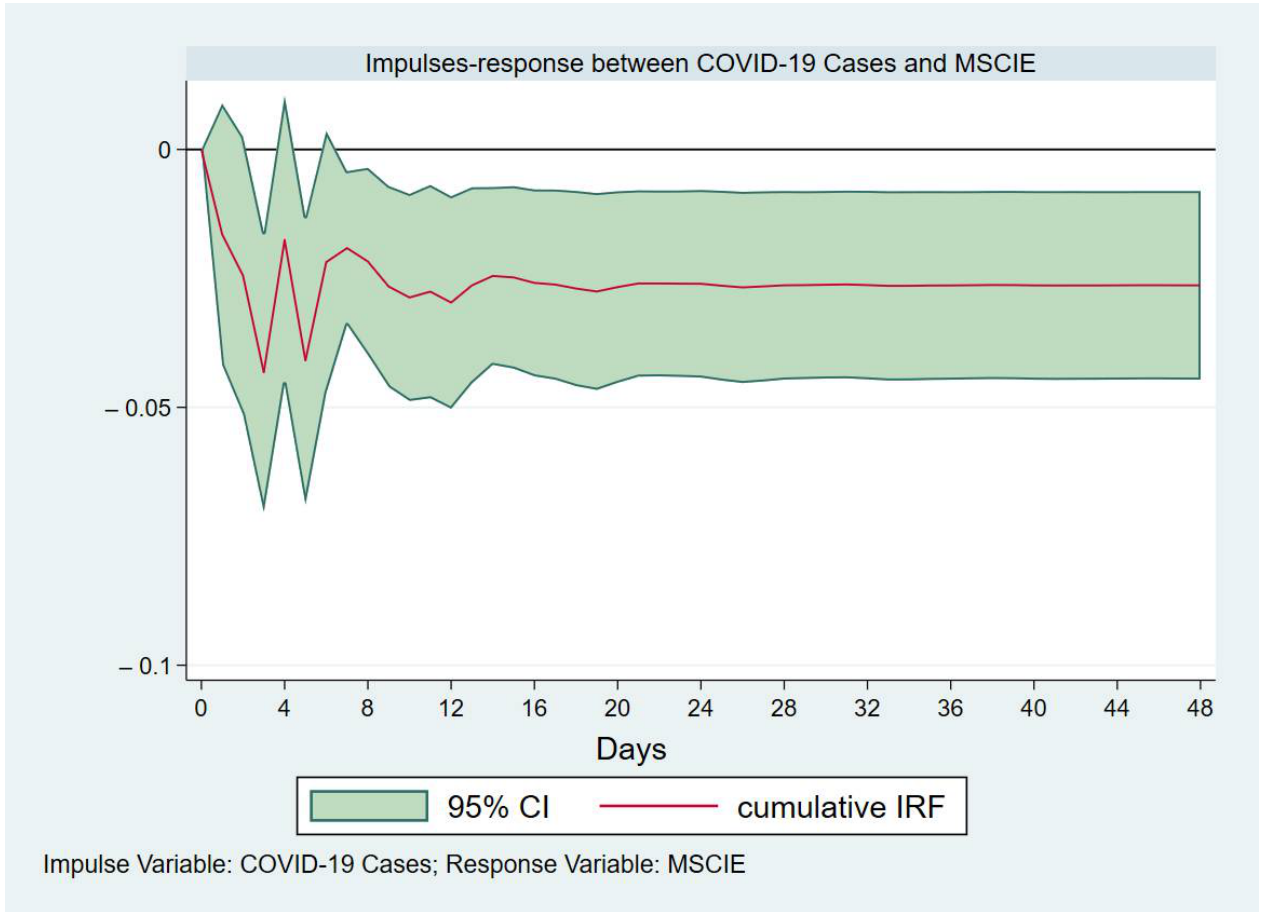
Figure 7. Cumulative impulse response of MSCIE to COVID-19 cases. Note: The red line represents the estimates, while the green bands represent lower and upper bounds to the 95% confidence intervals.